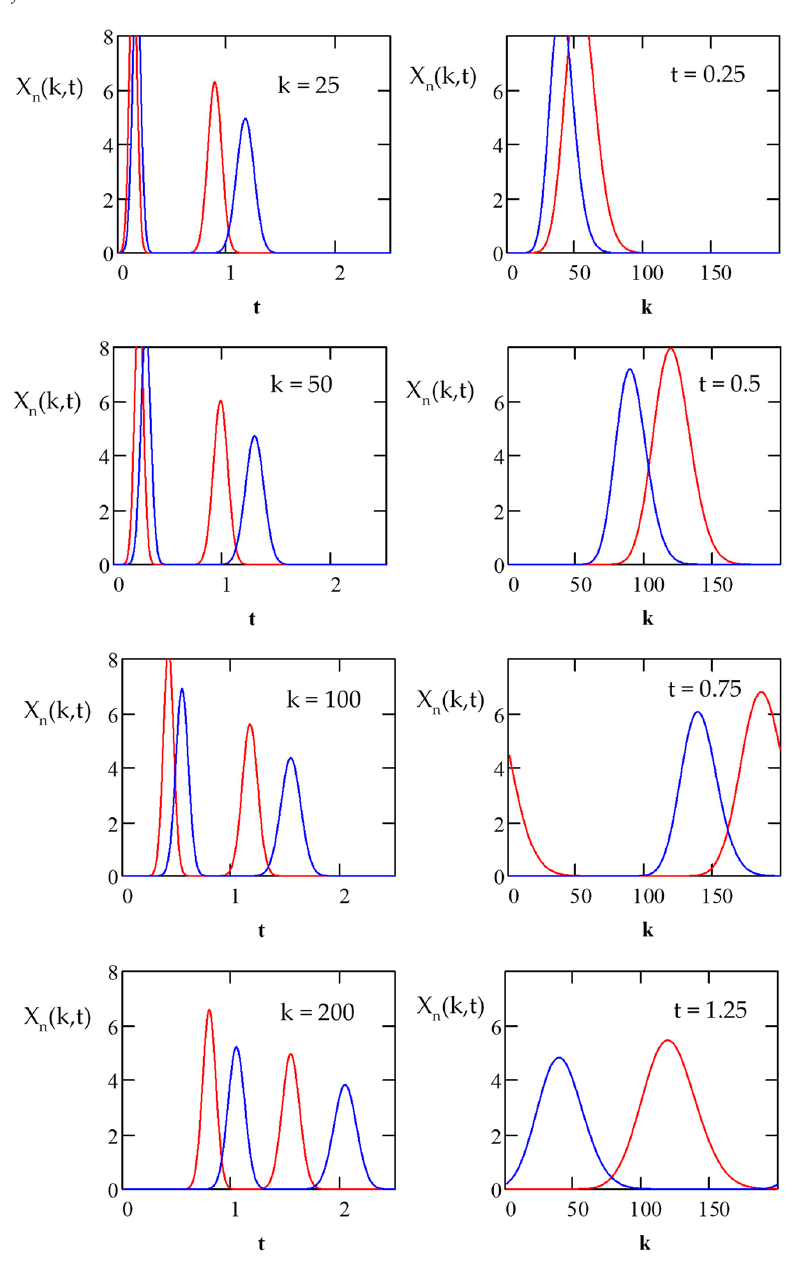
Figure 3. Simulation of the transport and separation of compounds K D 1 = 0.5 and K D 2 = 1 in the column with N = 200 during two cycles, calculated using Equations (1), (6), and (7). N = 200, S f = 0.5, t s = 0.1.